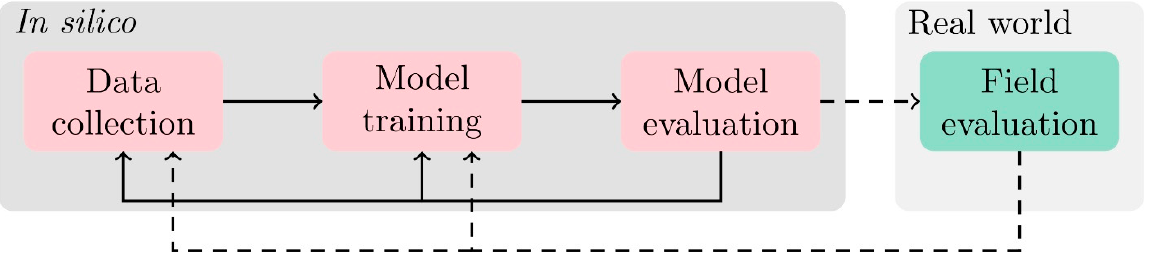
Figure 2. Schematic of the CVWID lifecycle. Most prior works have been restricted to in silico model development and evaluation based on a limited number of unique xylarium specimens that do not allow valid specimen level mutual exclusivity between the training and testing data. The sufficiency of CVWID systems can be validated only with context-informed field evaluation but this is mostly unexplored in prior works (see text for exceptions). The dashed lines are the paths not explored in existing works.